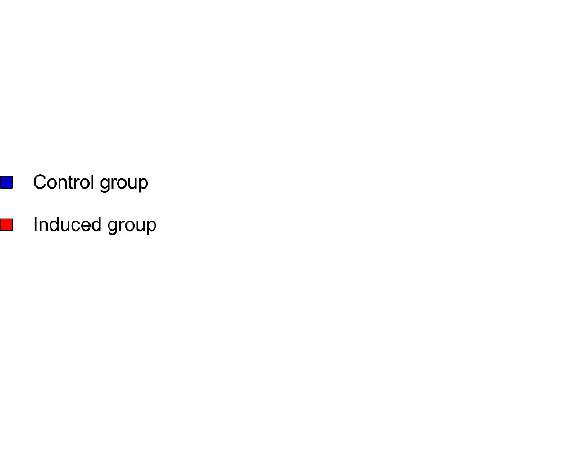
Figure 5. Elevation of blood glucose levels in zebrafish. Each value represents the mean ± SE. a p ≤ 0.05 when compared to normoglycemic control group. The letter indicates significant difference.